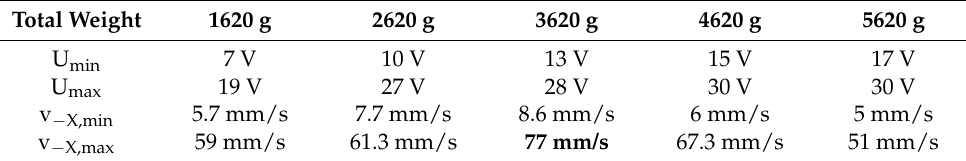
Table 2. Appropriate operating ranges for velocity in the − X direction. Total